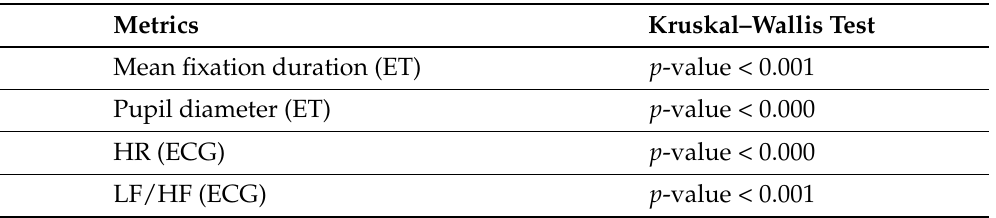
Figure 4. Top Left : change of pupil diameter; Top Right : change of fixation time; Bottom Left : ECC signal—change in heart rate due to ECG recording; Bottom Right : change of LF/HF metrics from ECG recording (sympathetic to parasympathetic response). 1 —the moment of the experiment start (without the use of the stressor), 2 —the moment when the patient’s vital signs began to drop on the monitor of the patient’s life, 3 —the stressor swiched on, 4 —the moment when the subject noticed the falling vital signs of the patient on the cardio monitor. Table 1. List of the metrics on the basis of which the stress was detected with the Kruskal–Wallis test